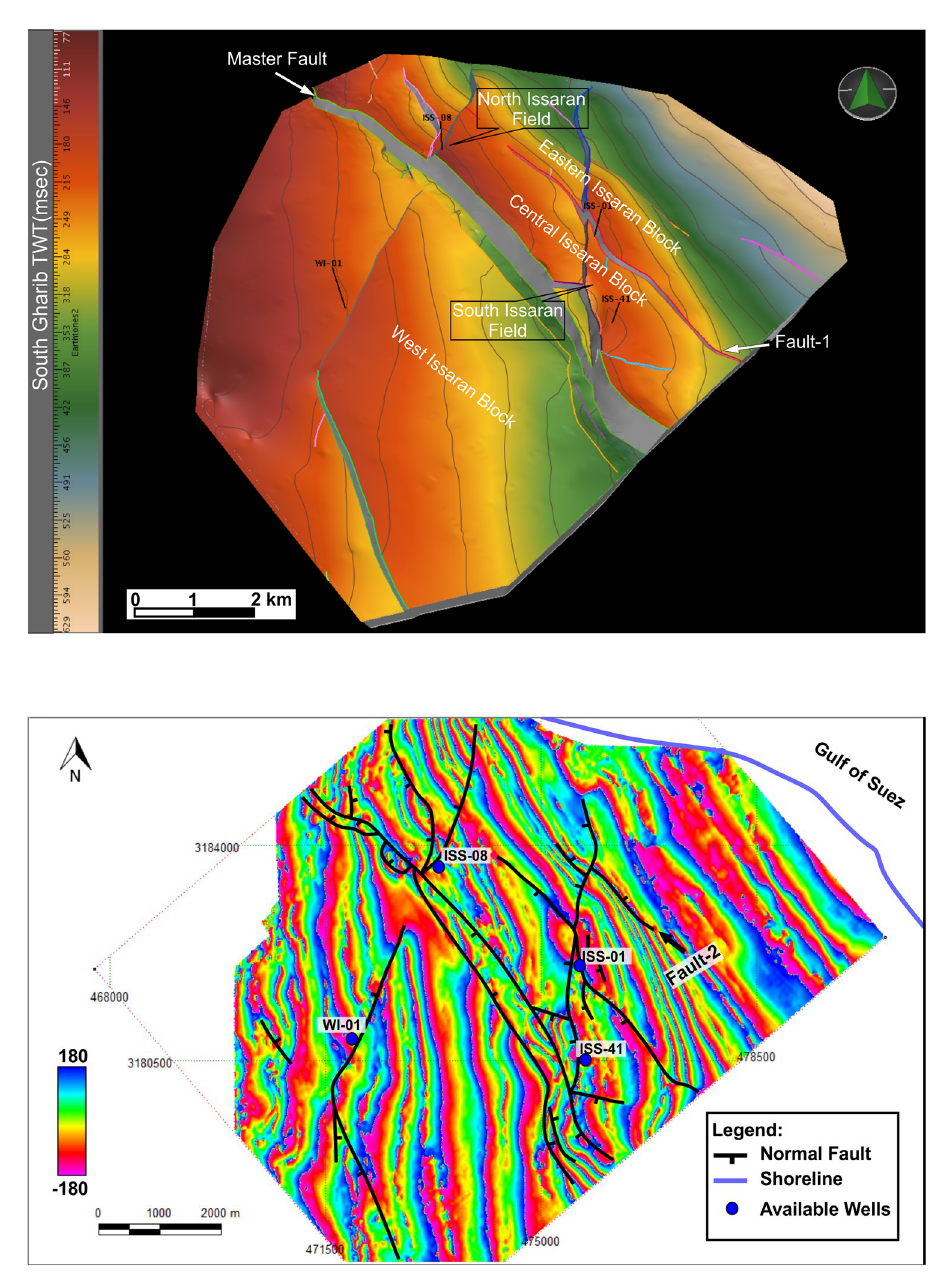
Fig. 12 3D structural frame- work for the Issaran oil field at the reflection horizons of South Gharib and Thebes formations expressed in TWT. It shows that the central and eastern parts of Issaran field have a relatively steep slope when compared to the western Issaran block